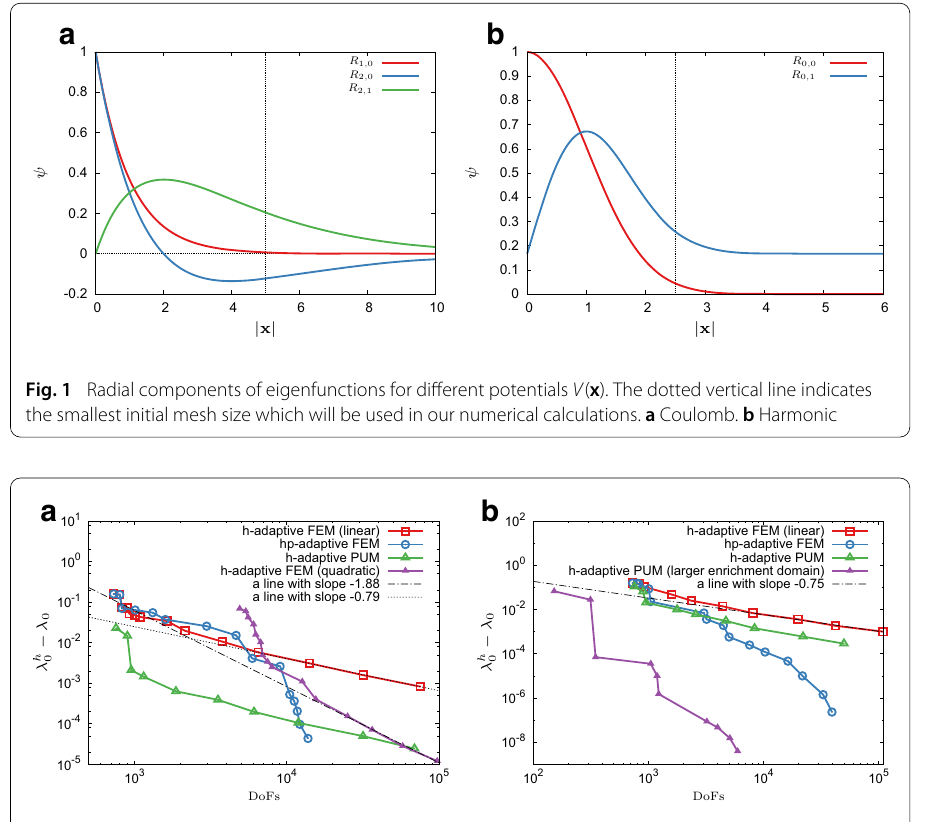
asymptotic convergence rate of the h -adaptive PUM with the default enrichment